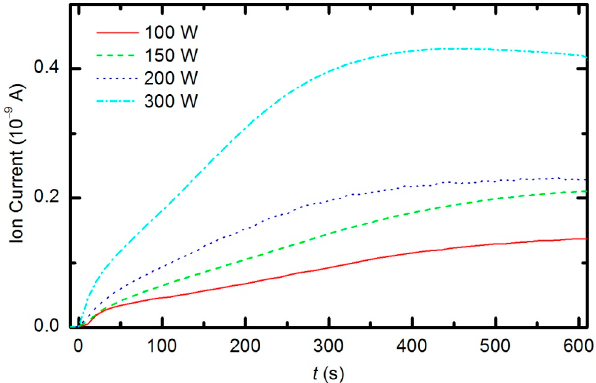
Figure 14. Time evolution of CO during sample treatment with oxygen plasma generated at various forward RF power levels.